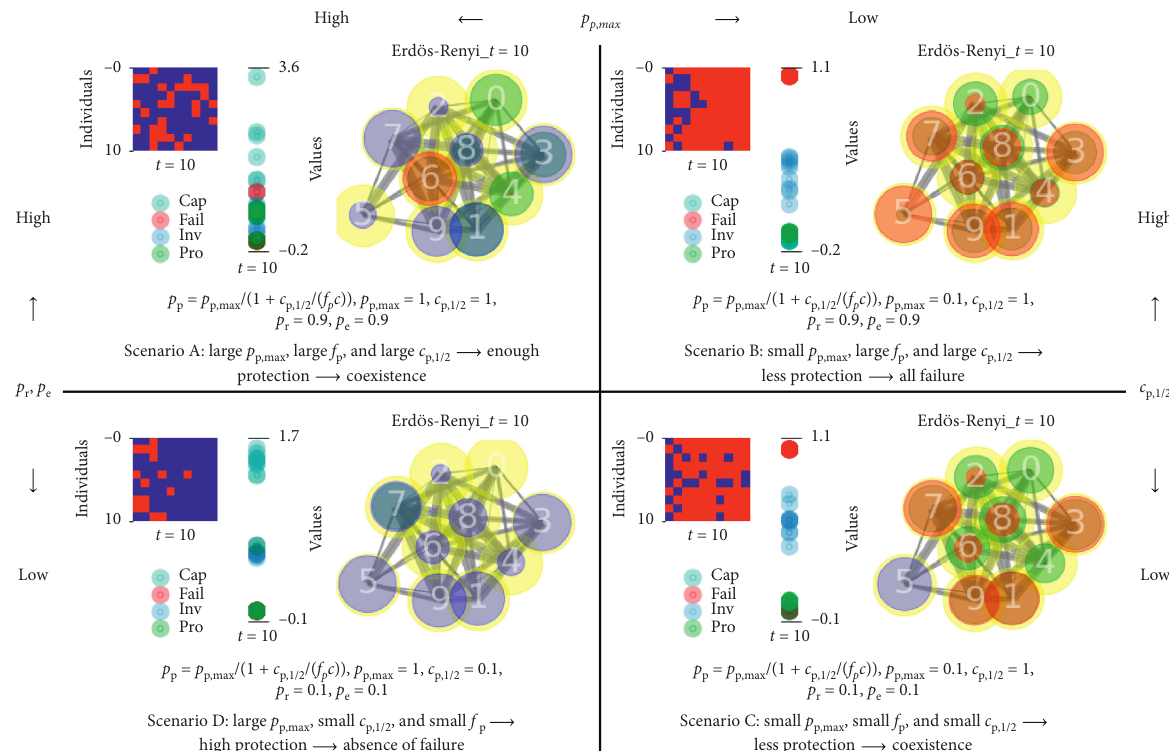
Figure 3: Protection dynamics against systemic risk. At each section, plots of the left-hand side show the matrix (horizontal axis � time step from 1 to 10, vertical axis � individuals (10), color of the matrix � failure state between fail (red) and absence of fail (blue)). The plots of the middle show each individuals’ parameter values at the time step ( t � 10: cyan: cap � capital ( c ), red: fail � failure, blue: inv � investment ( f ), p )). The plot on the right-hand side represents individuals’ dynamics within a random network; node green: pro � protection potential ( p p number � random label of each node, line width � eigenvector centrality, node color � states (failure (red) ←⟶ (gray) absence of failure, green � protection potential, yellow � initial structure of the state without failure and protection). Initialized parameters of the simulations � 0.4, f � 0.5, f � 0.1, s � 1, μ � 0.0, σ � 0.1, p � 0.1, p � 0.3, and t � are follows: nodes n � 10, connection p � 0.9, p � 1, f p0 p1 m n l